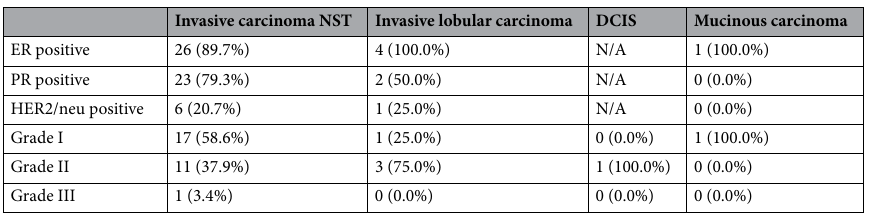
Table 2. Tumor characteristics specified per breast cancer subtype, hormonal receptors, and tumor grade. ER Estrogen receptor, PR Progesterone receptor, HER2/neu Human epidermal growth factor receptor 2, NST No special type, DCIS Ductal carcinoma in situ, N/A Not